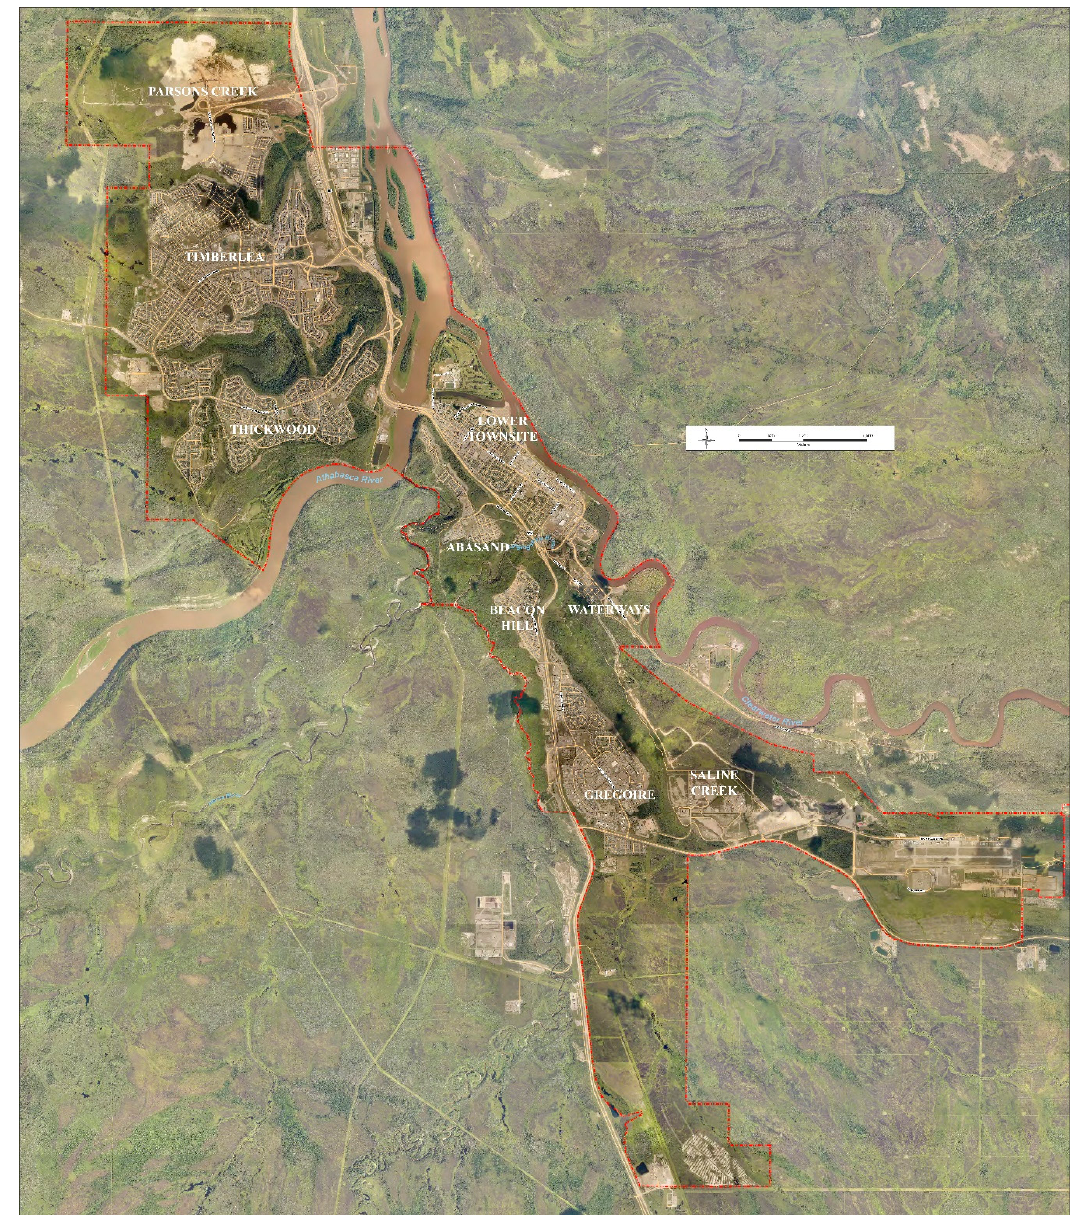
Figure 2. Fort McMurray neighbourhoods. Source: Regional Municipality of Wood Buffalo.